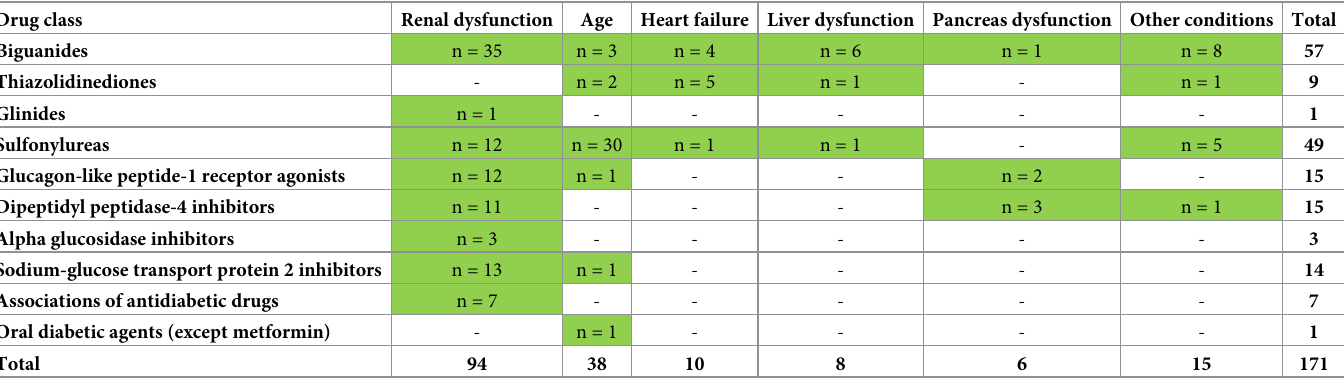
Table 1. The number of explicit mentions of PIPADs, classified by organ or by patient age.